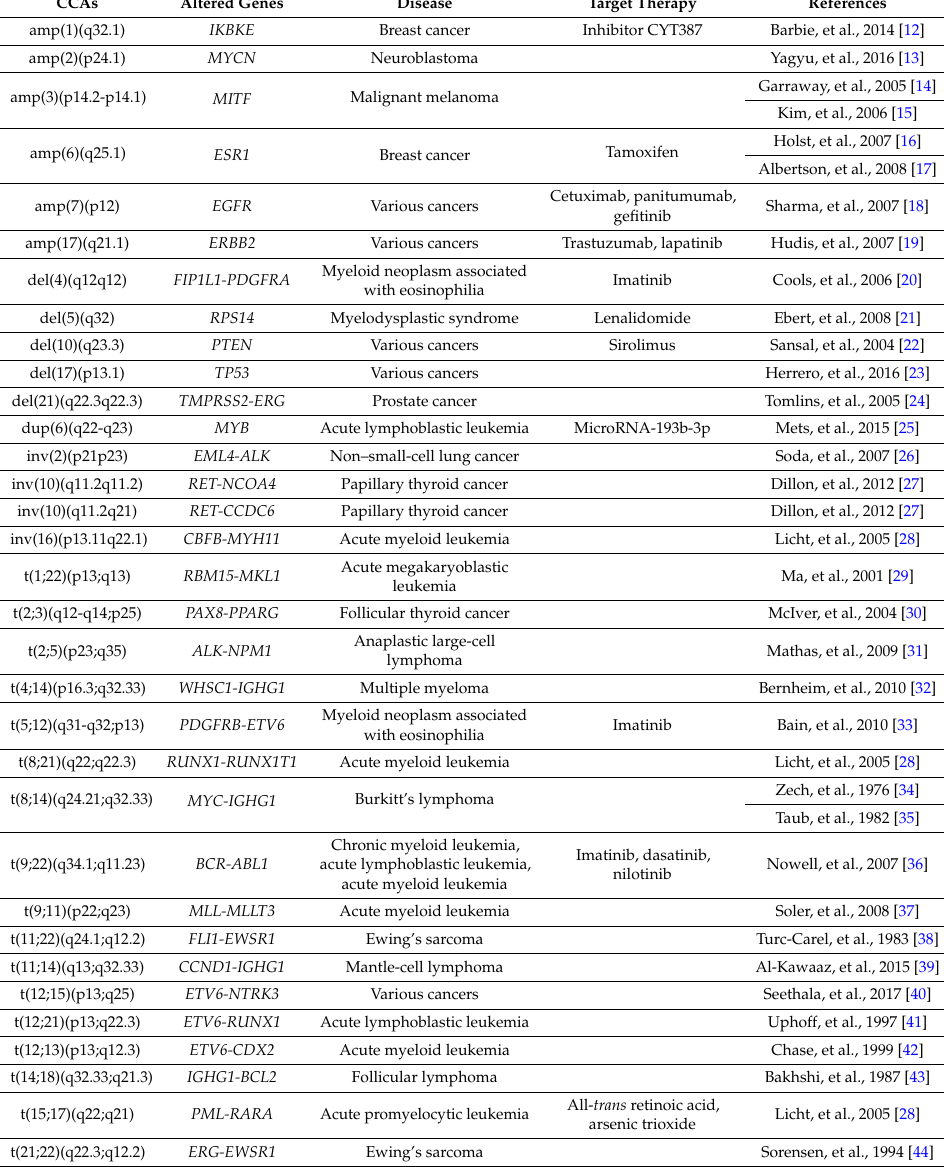
Table 1. Representative examples of clonal chromosomal alterations (CCAs) characteristic of solid and hematological